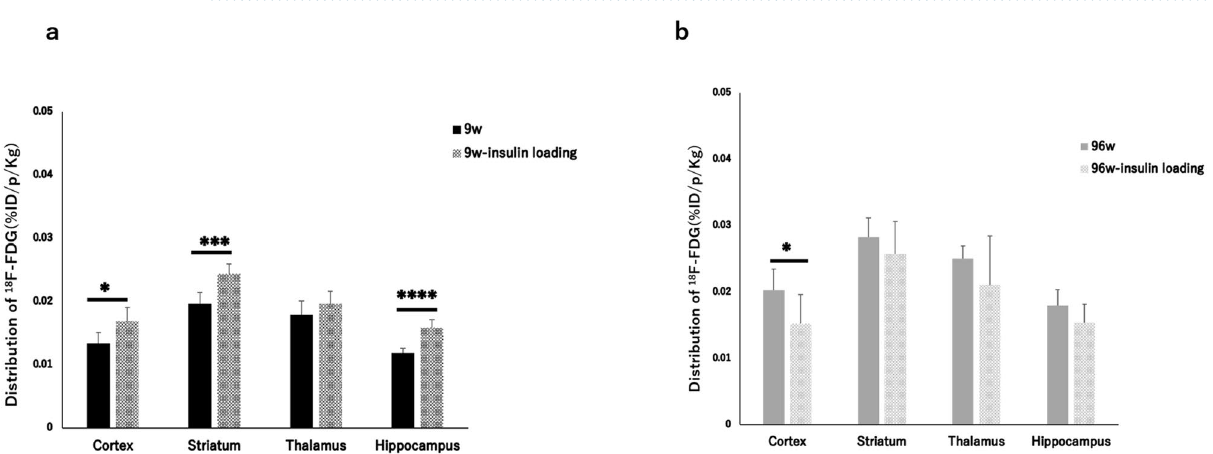
Figure 3. 18 F-FDG distribution in brains with and without insulin loading in young and aged groups. * P < 0.05, *** P < 0.001, **** P <